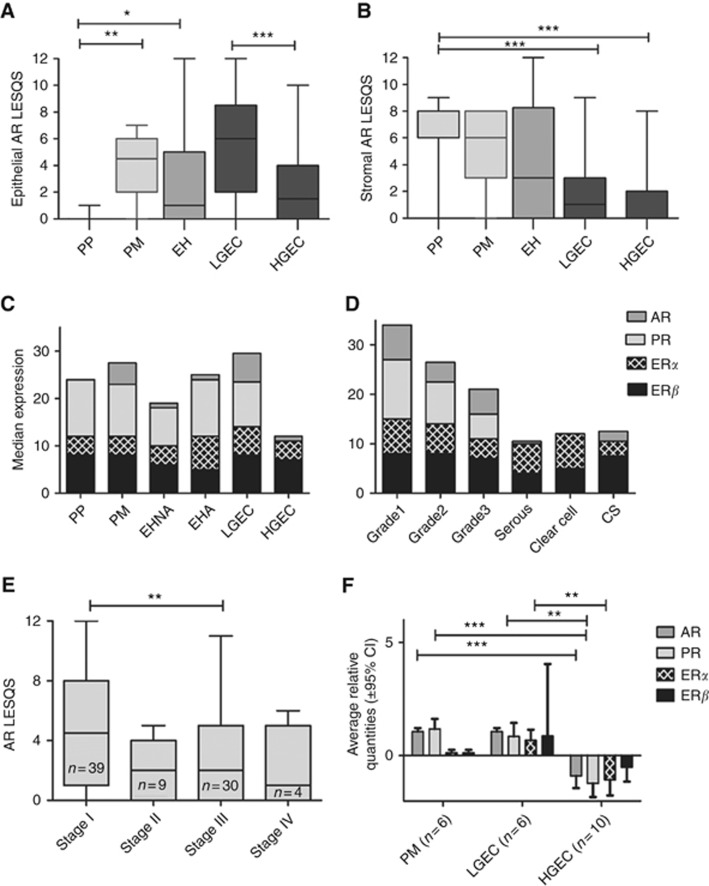
Protein and mRNA expression levels for Steroid receptors in endometrial cancer. (A) Expression of AR in the epithelium and (B) stroma of healthy PP, PM, endometrial hyperplasia (EH), LGEC and HGEC. (C, D) Stacked graphs represent the median expression of AR, PR, ERα and ERβ in (C) PP, PM, endometrial hyperplasia no atypia (EHNA), endometrial hyperplasia with atypia (EHA), LGEC and HGEC; (D) endometrial cancer subtypes, including carcinosarcoma (CS). (E) Expression of AR protein according to endometrial cancer stage. (F) Steroid receptor mRNA levels in human endometrial tissue, PM, LGEC and HGEC. *P<0.05, **P<0.001, ***P<0.0001.